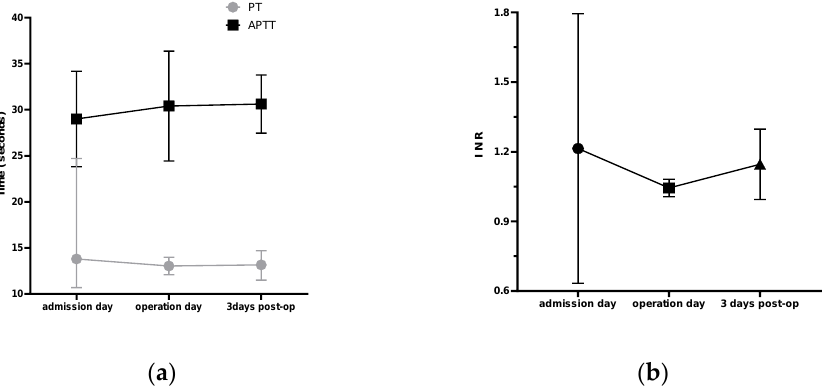
Figure 3. Trends in blood coagulation indicators. It shows trends of the PT, APTT ( a ), and INR ( b ) at three different timepoints during the STN-DBS perioperative period. post-op: post-operation.